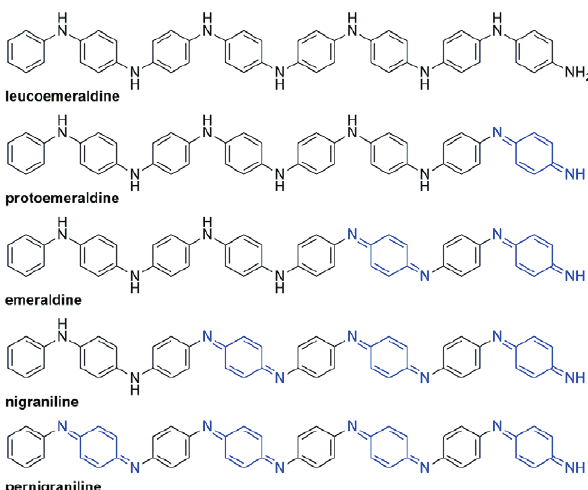
Figure 13. The full series of aniline oxidation products as proposed by Green and Woodhead in